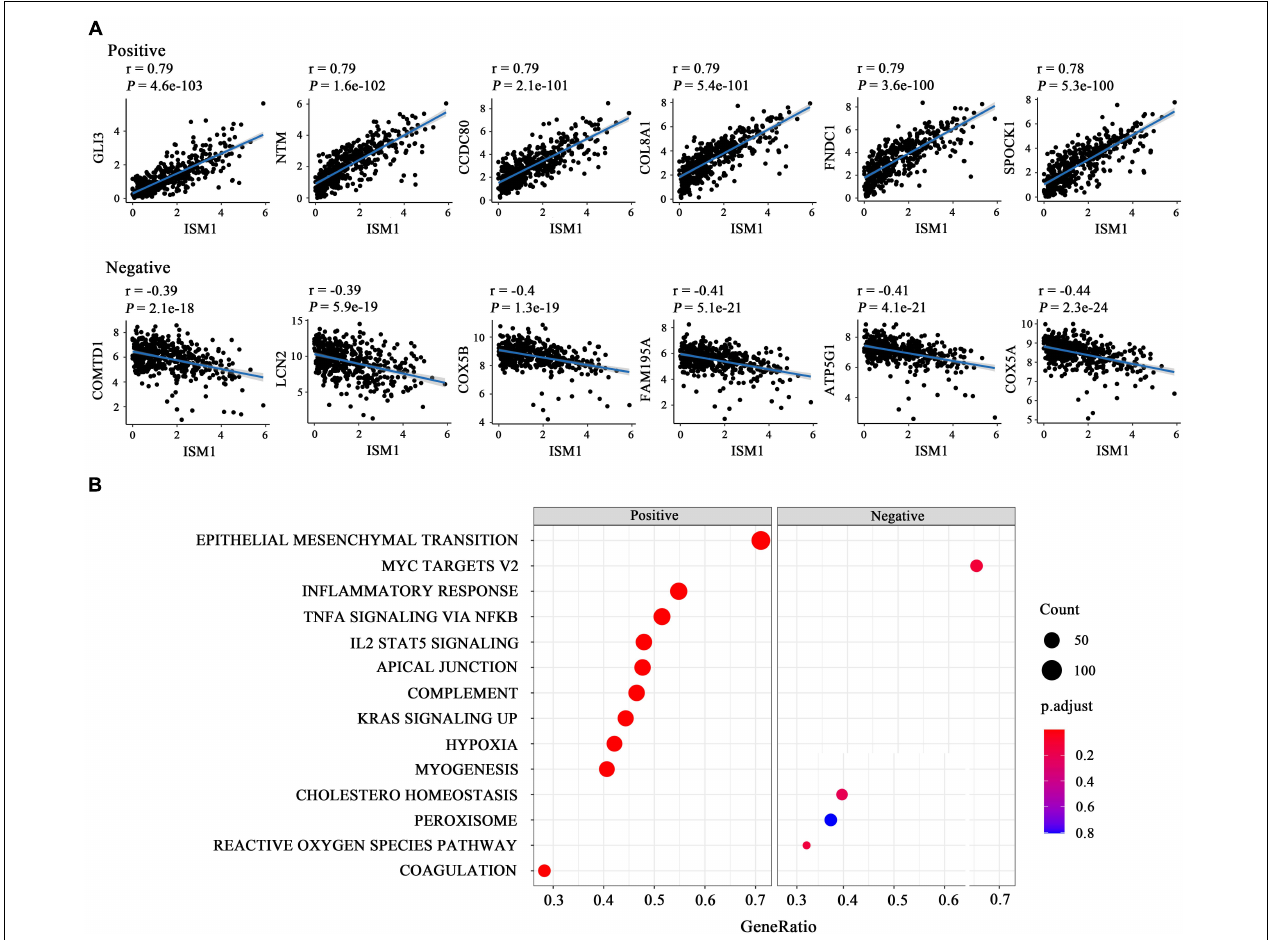
FIGURE 4 | Functional enrichment analysis of ISM1 in CRC. (A) Correlation between ISM1 and the remaining 19505 genes. The top six positively and negatively correlated genes are shown. (B) GSEA of the 19505 genes was performed using Pearson’s correlation, and the top 10 positively and negatively correlated pathways are shown. Pathways in the left box were found to be positively correlated with ISM1, while those in the right box were found to be negative correlated with ISM1. The color of the dots varies from blue to red, representing the significance of changes: red indicates statistical significance. When many genes were found to be correlated with ISM1 in a pathway, the size of the dot larger. The horizontal axis represents the ratio of correlated genes among all the genes in each pathway. P < 0.05 is statistically